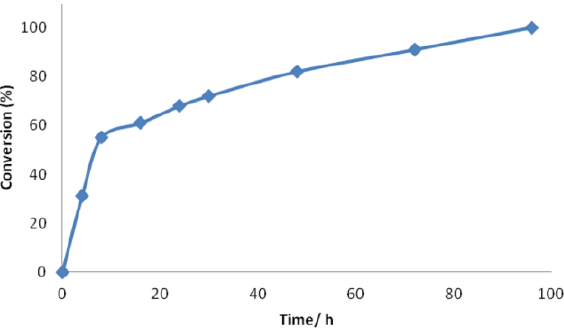
Figure 6. Conversion rate of anthranilic acid 3a versus time.